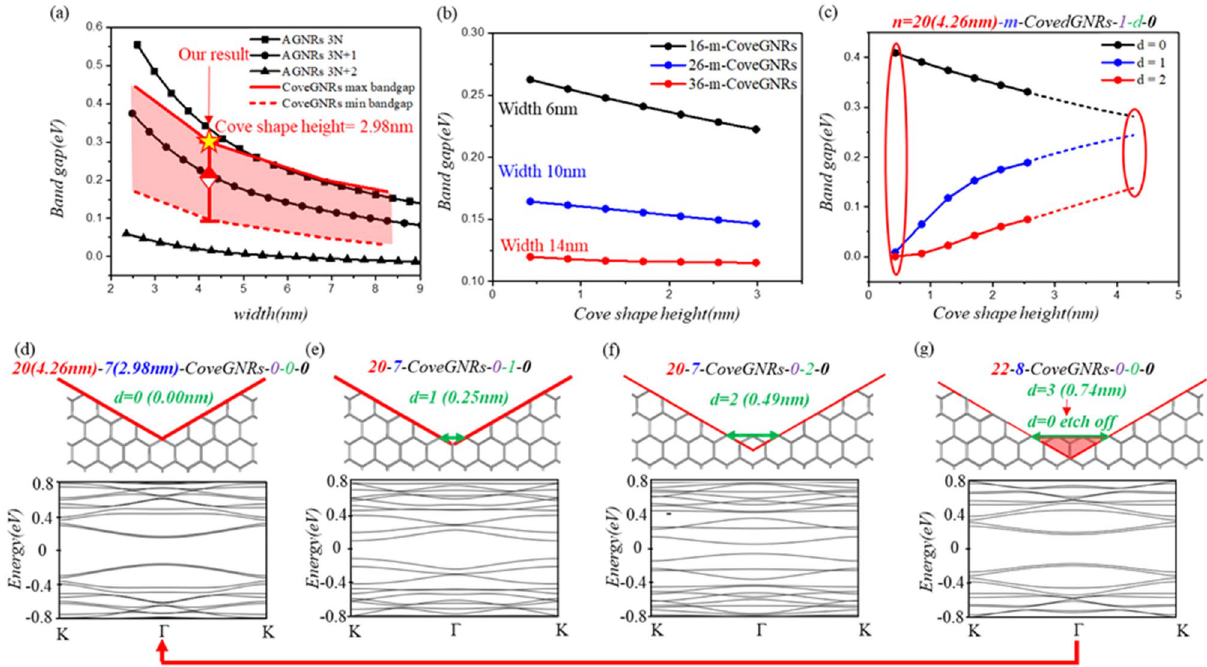
Figure 2. ( a ) Bandgap variation as function of the width in CoveGNRs compare with the AGNRs. ( b ) Bandgap variation of CoveGNRs in different cove shape size (label in the number of atoms along the height of cove shape) in case the width 6, 10, 14 nm. ( c ) Bandgap variation versus zigzag edge amount ( d ) in the spacing of cove shape size of Cove GNRs. The cove shape of CoveGNRs increasing can eliminate the zero band gap caused by zigzag edge segment of Cove GNRs in the anisotropic annealing. ( d – g ) The spacing between the cove structure with zigzag edge segment. As the zigzag edge segment increasing from d = 0 to d = 2, the zigzag edge can be etched into armchair